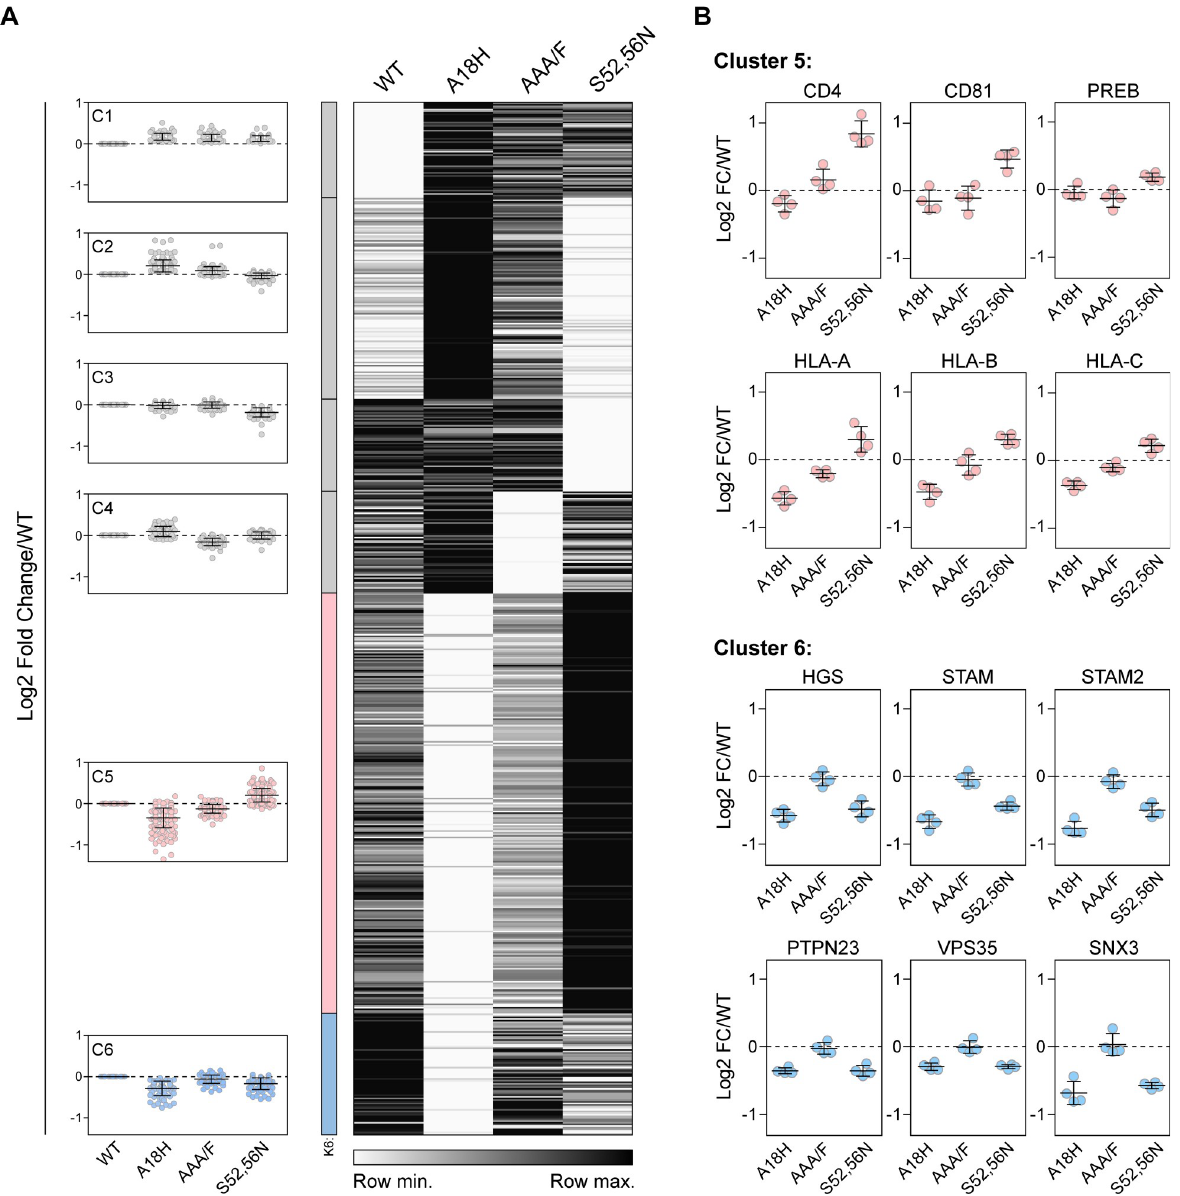
Fig 6. Heat map and k-means clustering of proteins (384) for which any Vpu-mutant was significantly different from wild type. (A) Heatmap of the relative abundance of proteins measured in Vpu-APEX2 WT and mutant samples. The heatmap was sorted into 6 clusters by k-means clustering analysis; the cluster profile is shown on the left. Data are presented as the fold change in protein abundance relative to WT. (B) Cluster 5 contains known and potential targets of Vpu, including CD4, CD81, and HLA-C. k-means cluster 6 contains potential serine-dependent cofactors of Vpu, including endosomal sorting proteins. Data are derived from duplicate samples per condition, from two independent experiments.